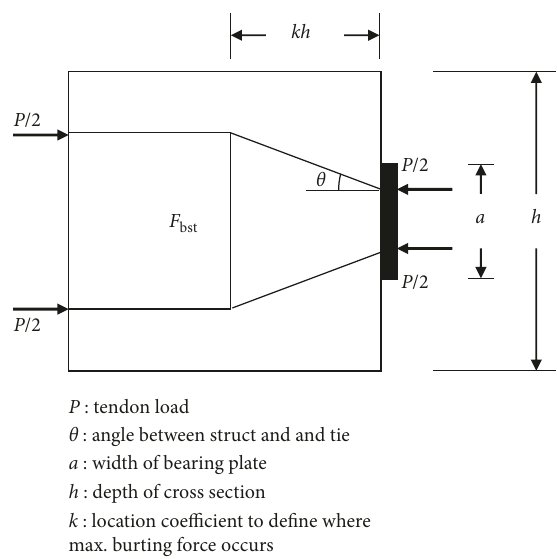
Figure 1: Strut-and-tie model (reproduced from M¨orsch [1], under the Creative Commons Attribution license/public